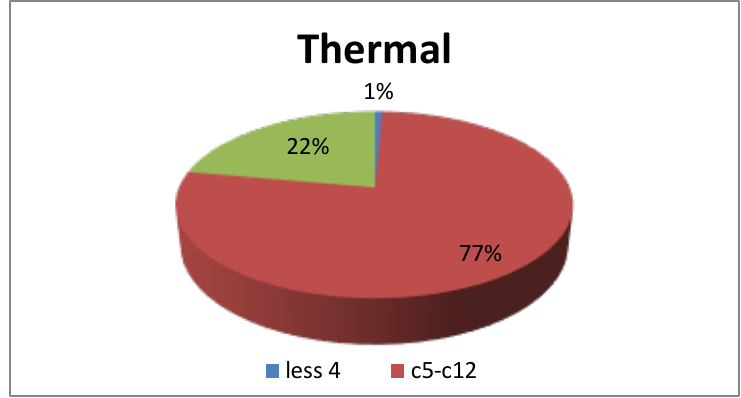
Figure 7: Thermal cracking